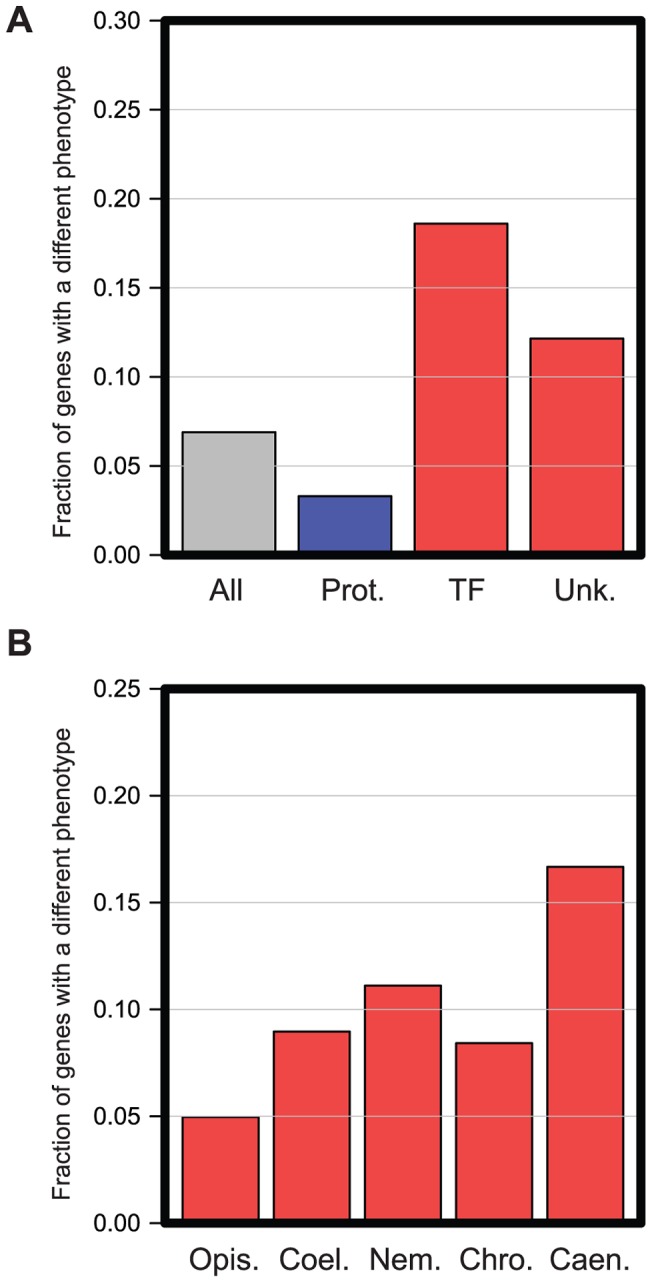
Functional enrichment in genes with different in vivo functions in C. elegans and C. briggsae.
A. All 1333 genes analyzed were manually placed into the functional categories described in Kamath et al.
[14]. The graph shows the proportion of genes that have different RNAi phenotypes in several different functional classes: all genes analyzed (‘All’), genes annotated to have roles in Protein Synthesis (Prot. Synth.), Transcription Factors (‘TF’), or genes of Unknown function (‘Unk’). Classes with significantly fewer genes with different RNAi phenotypes are shown in blue; those with statistically increased numbers are shown in red. Enrichments are significant with an FDR of 0.05 (Hypergeometric test). B.
RNAi phenotypes differ most for more recently evolved genes. All 1333 genes analyzed were placed into five classes based on their evolutionary age as described in Methods. The most ancient genes could be dated back to the emergence of the Opisthokta lineage (‘Opis.’), then becoming progressively younger, we could date sets of genes back to the emergence of the Coelomata (‘Coel.’), Nematoda (Nem.), Chromadorea (‘Chro.’), and finally some genes had arisen so recently that they were only detectable in Caenorhabditis species (‘Caen.’). In each case, the graph shows the proportion of genes in each evolutionary class that had a different RNAi phenotype.